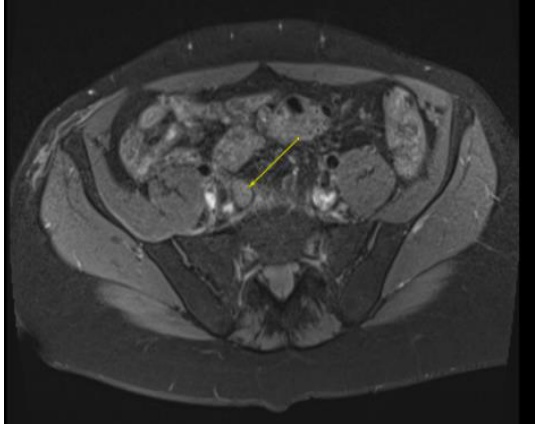
Figure 3. MRI in the axial view T1 TSE FS PRE showing hyperintense linear non-enhancing structure consistent with ultrasound finding of thrombosed dorsal penile veins. Figure 4. MRI in the axial view T1 TSE FS pre-showing 11 mm R common iliac lymph node.